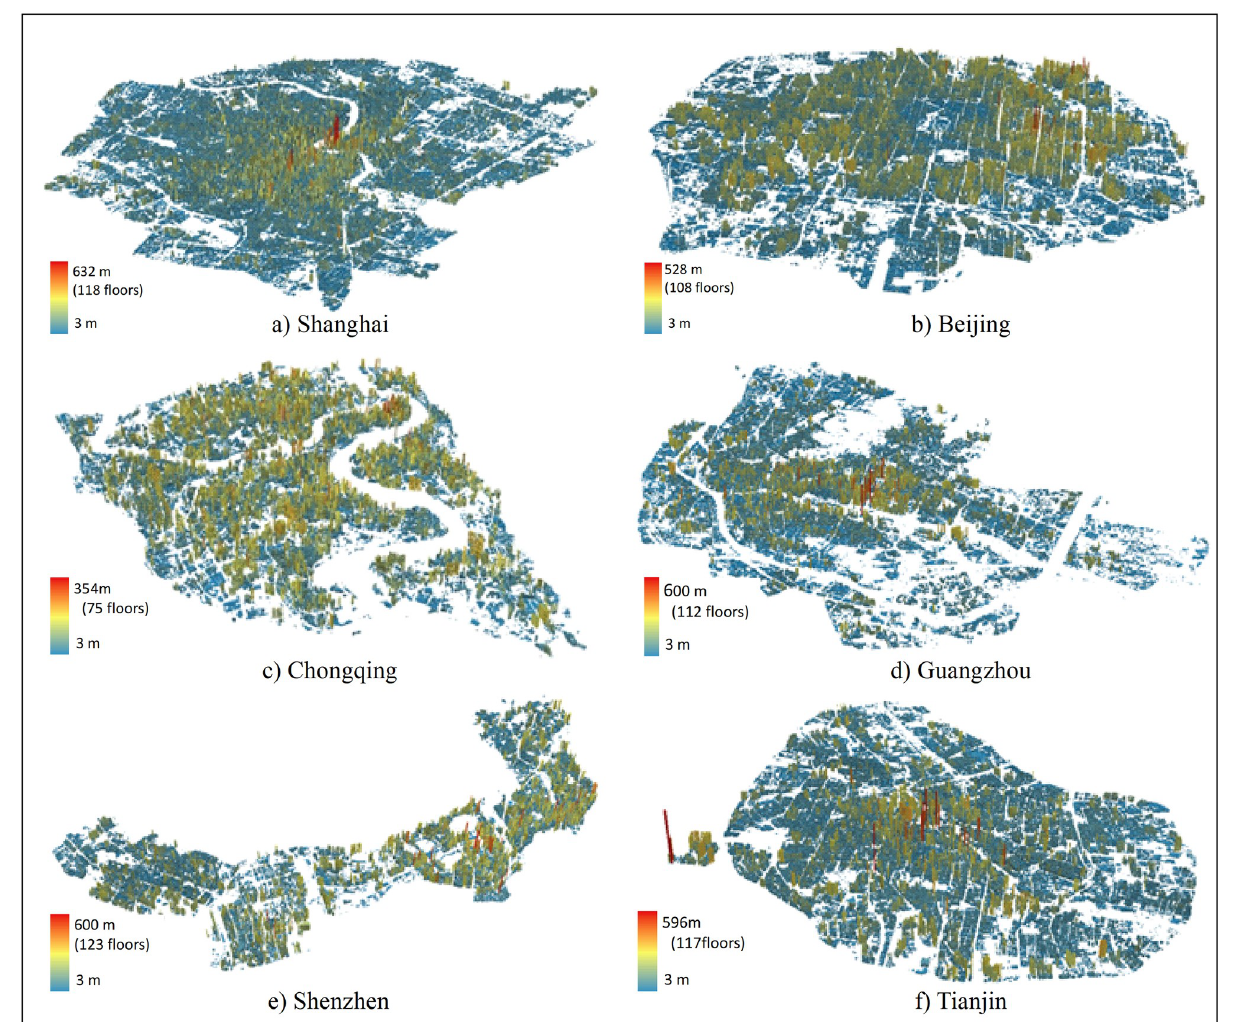
Fig 2. Three-dimensional map of building